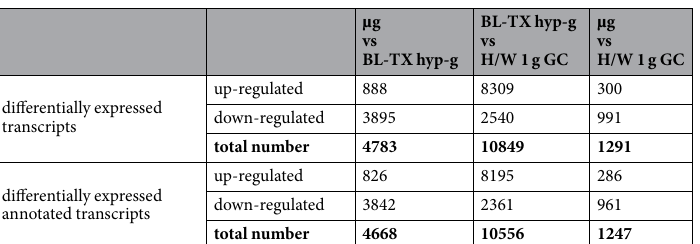
down-regulated in microgravity and vice versa. None of the identified transcripts was regulated in the same direction in hypergravity and in microgravity (Fig. 5). We continued this analysis with the data from the subor- bital ballistic rocket experiment and identified 3574 (3514 annotated) transcripts (Fig. 6) that were differentially expressed in hypergravity and in microgravity and revealed the same observation: All transcripts, except for one, were expressed also in the opposite direction in hyper- and microgravity, respectively (Fig. 6). Due to the nature of the flight profiles, the microgravity phase always followed the hypergravity phase in both flight experiments.